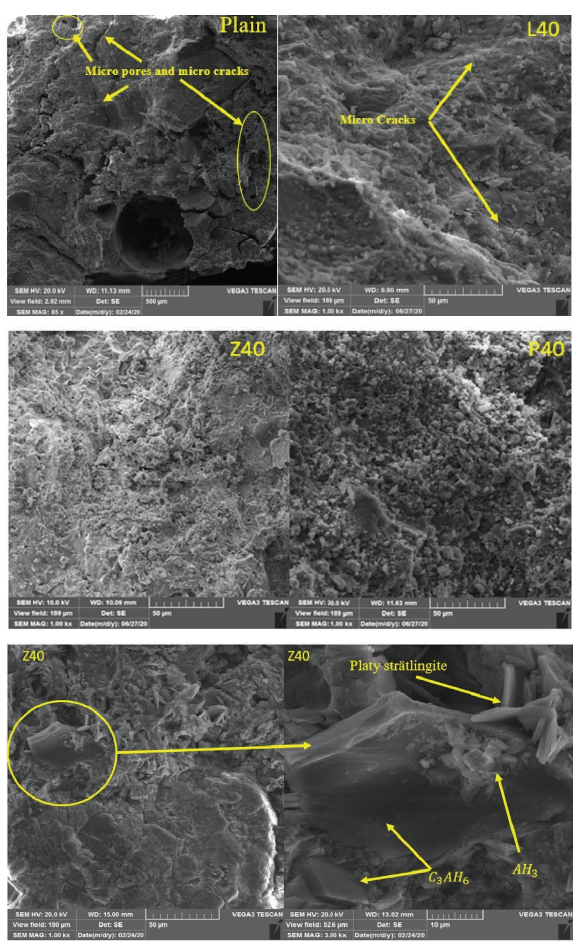
Figure 15: SEM images of plain, Z40, L40, and P40 mixture at the age of 90days.